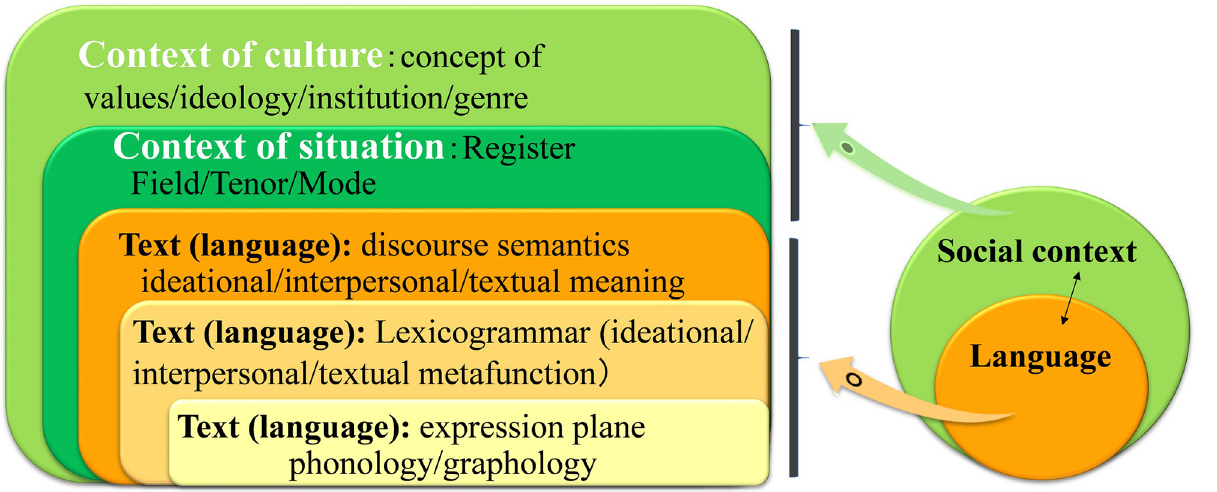
Fig 3. Bidirectional relationship between language and social context and the stratification of language. This is based on Martin [35].